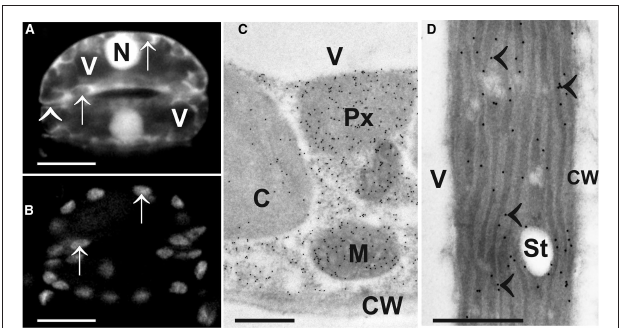
FIGURE 3 | Images show the typical distribution of glutathione. (A) Monochlorobimane staining in guard cells of the upper epidermis of tobacco cells in the light microscope. Fluorescence was observed in cytosol and nuclei (N) but not in vacuoles (V) and cell walls (arrowhead). Additionally, no fluorescence could be observed in chloroplasts (arrows in A and B ) which can be best identified when comparing the autofluorescence of chloroplast (B) with monochlorobimane staining (A) . Transmission electron micrographs show the subcellular distribution of glutathione (C,D) in mesophyll cells of leaves from Arabidopsis Col-0 plants. Glutathione-specific labeling could be observed in different concentrations in mitochondria (M), chloroplasts (C), peroxisomes (Px) but not in vacuoles (V) and cell walls (CW). Glutathione-specific labeling was observed in the stroma as well as inside the thylakoid lumen (arrowheads) when plants were exposed to high light intensities of 700 µ mol m − 2 s − 1 . Bars in (A,B) = 10 µ m, (C,D) = 0.5 µ m.